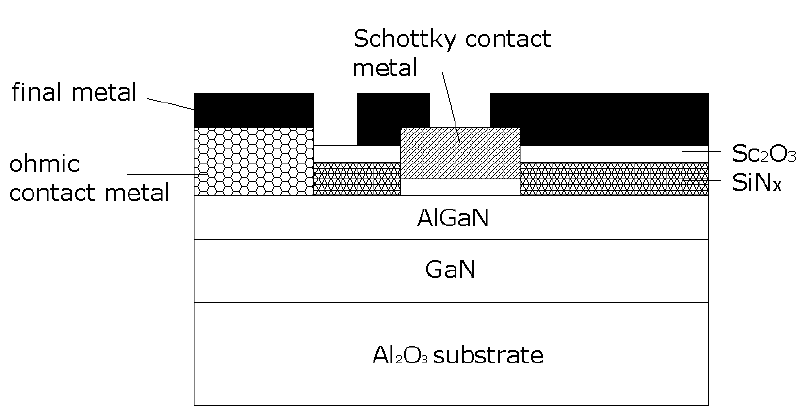
Figure 22. Forward I-V characteristics of MOS-HEMT based diode sensor at 400 °C measured under pure N